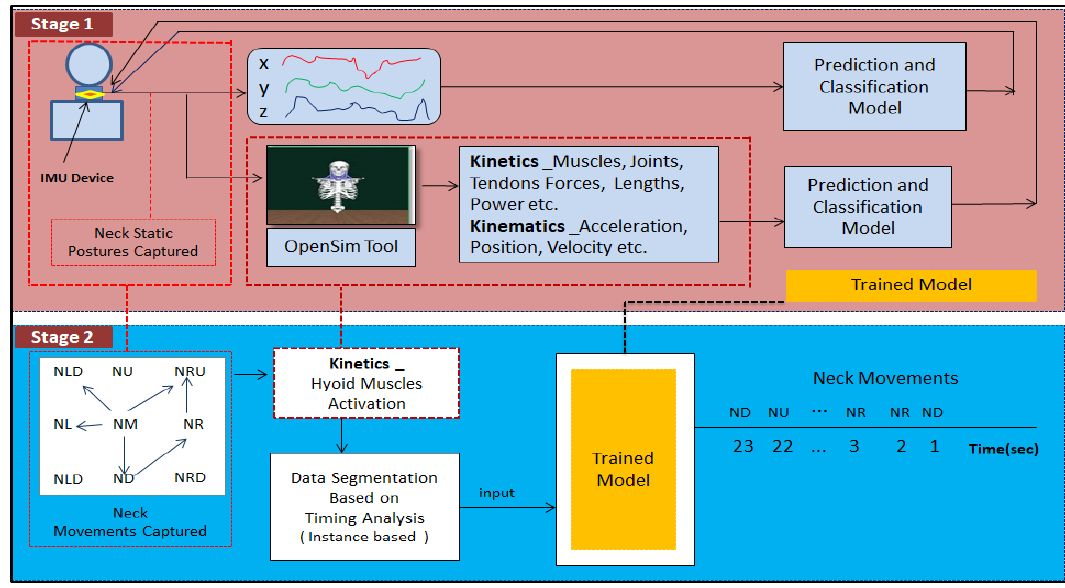
Figure 10. Block diagram of the research workflow.